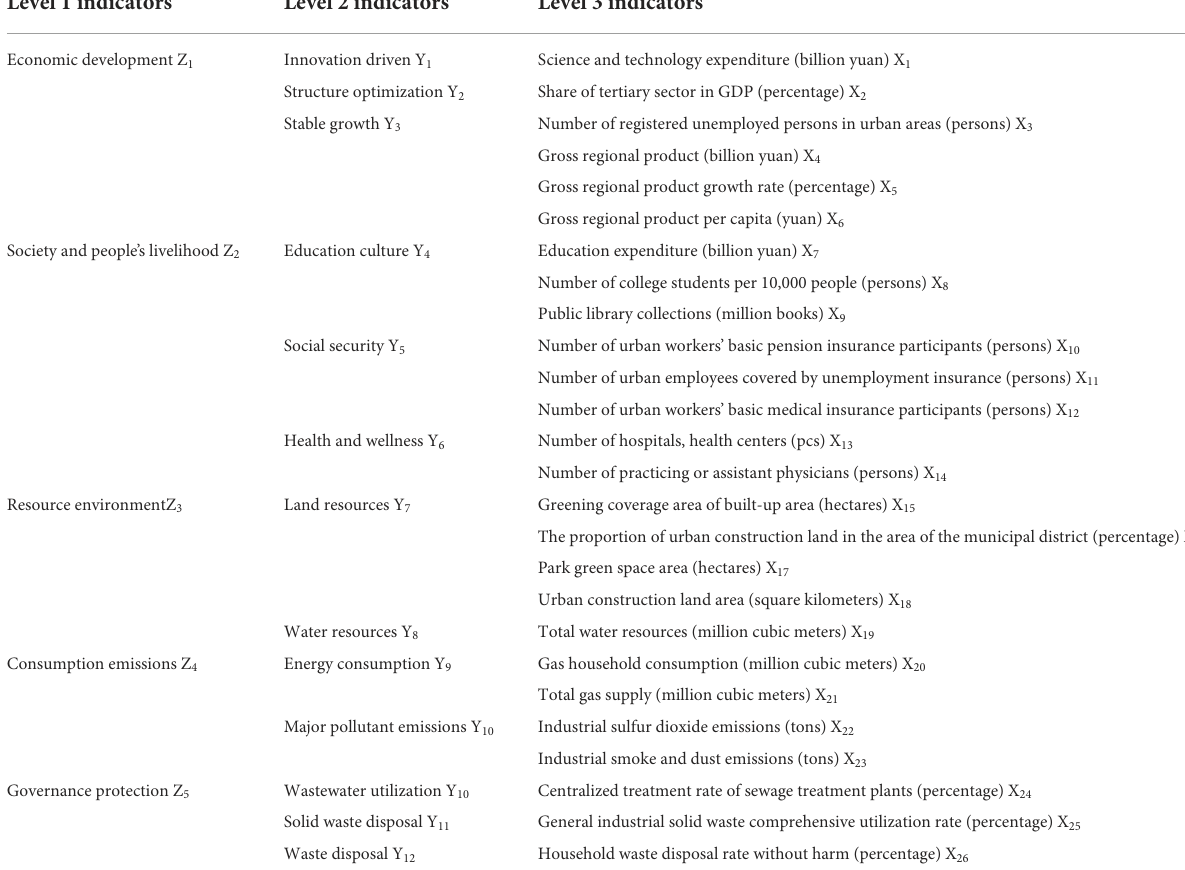
TABLE 1 Urban sustainable development evaluation index